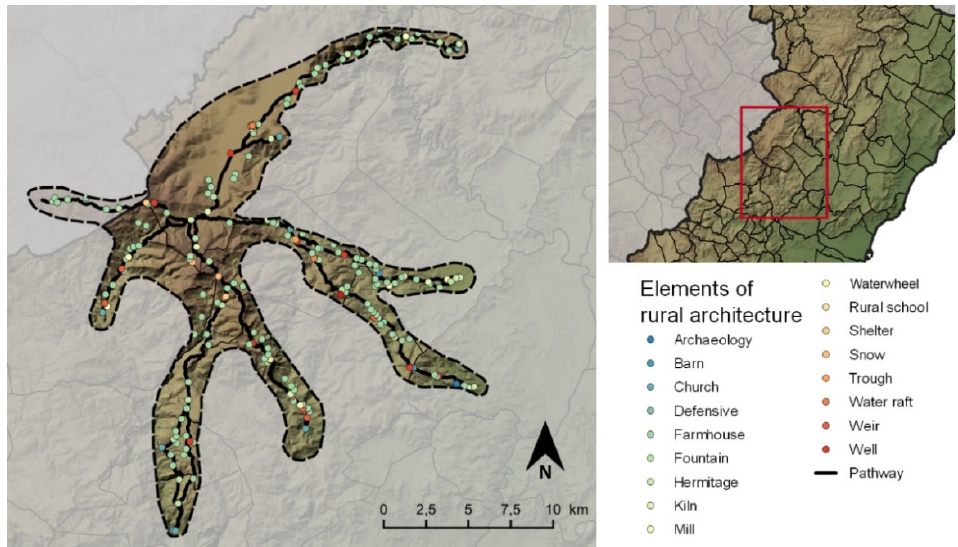
Figure 6. Planimetry of the Penyagolosa area with the georeferenced and categorised elements.